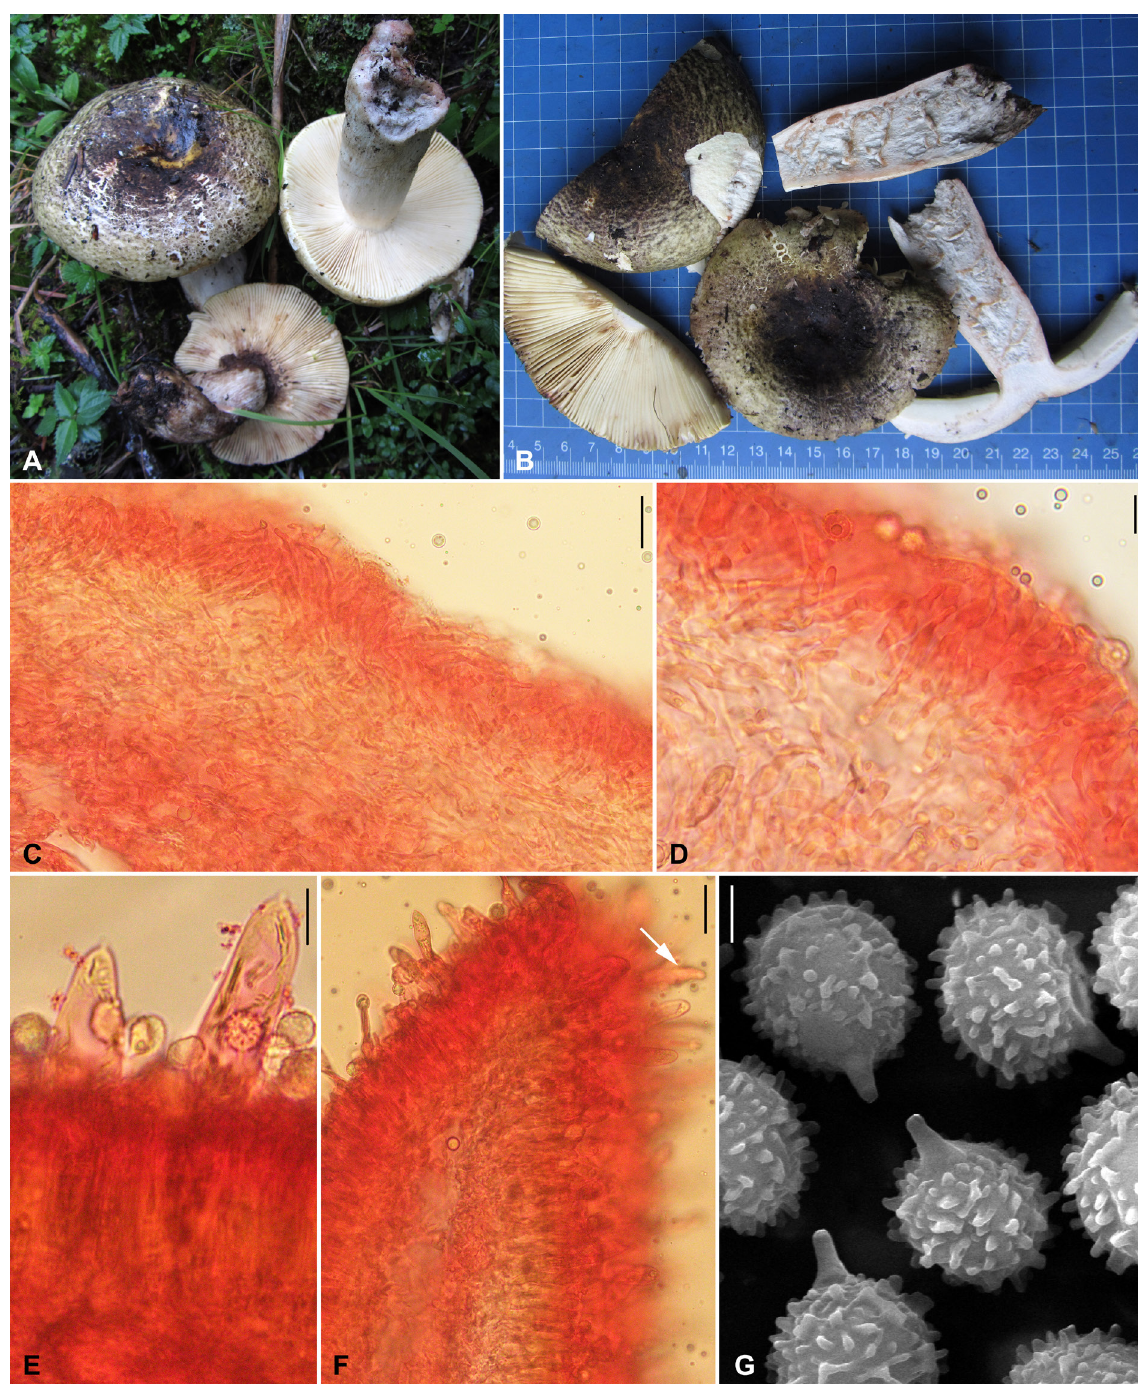
Fig. 4. Russula purpureozonata K.Das, A.Ghosh & Buyck sp. nov. (from holotype, KD 18-003 ). A–B. Fresh and dissected basidiomata in the field and basecamp. C–D. Transverse section through pileipellis showing elements. E. Transverse section through lamellae showing hymenial cystidia near the lamellae sides. F. Transverse section through lamellae showing hymenial cystidia near the lamellae edges (indicated with white arrow). G. SEM images of basidiospores. Scale bars: C = 100 μm; D–E = 10 μm; F = 50 μm; G = 2